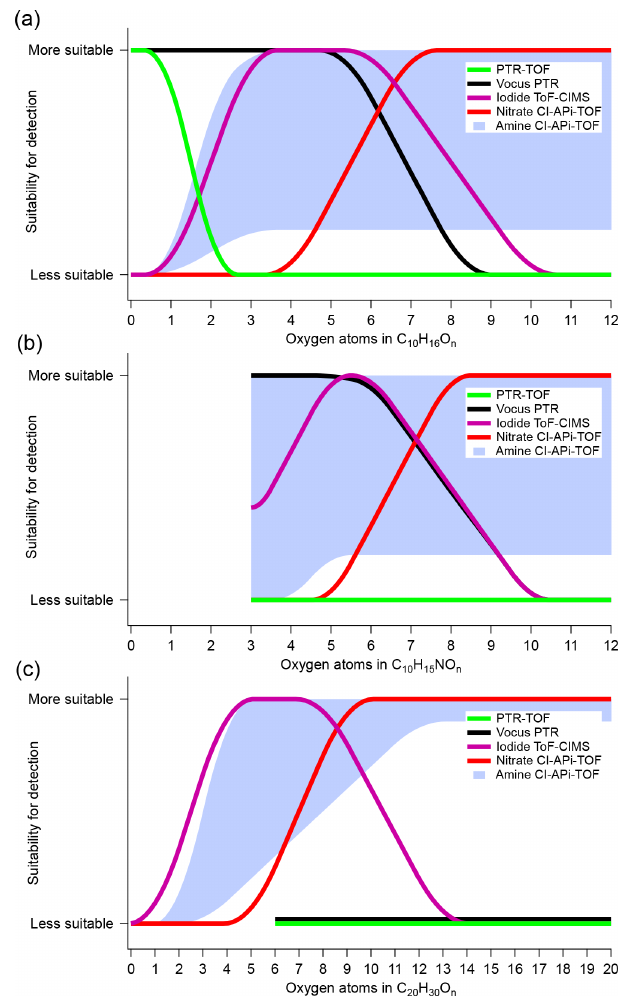
Figure 6. Estimated detection suitability of the different CIMS techniques for α -Pinene and its oxidation products, plotted as a function of the number of oxygen atoms. Each panel symbolizes a compound group: monomers (a) , organonitrate monomers (b) and dimers (c) . The figures are indicative only, as none of the reagent ion chemistries are direct functions of the oxygen atom content in the molecules. See text for more